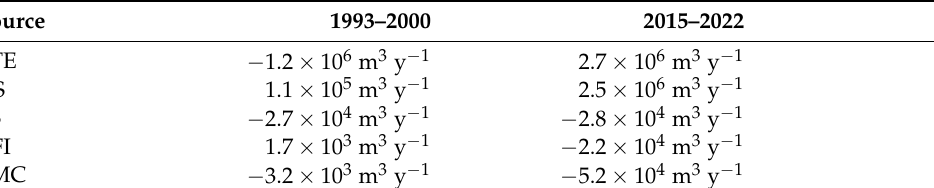
Table 1. Estimated volume change rate of the five deformation sources. Source